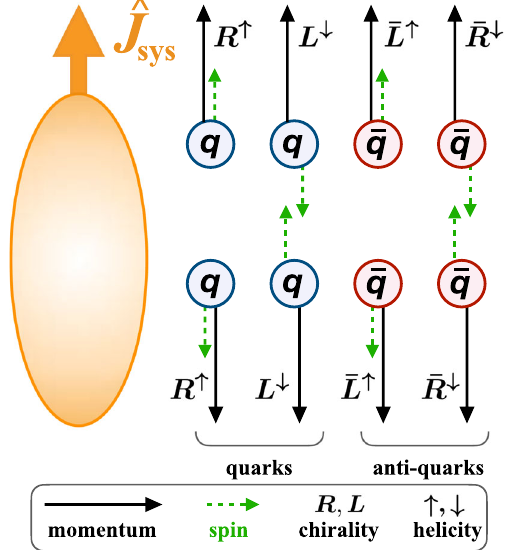
Fig. 1 Schematic picture of spin polarization, momentum, chirality and helicity of light quarks and anti-quarks projected onto the direction of the global angular momentum ˆ J sys of a vortical quark–gluon plasma